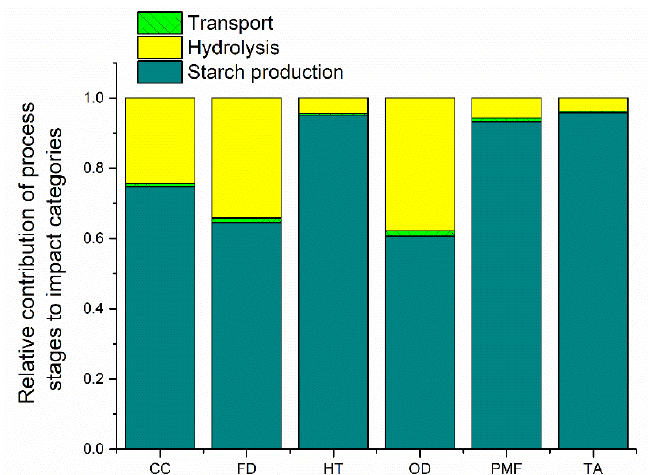
Figure 4. LCA results obtained for the relative contribution of process stages to the evaluated impact categories in glucose production from maize starch.